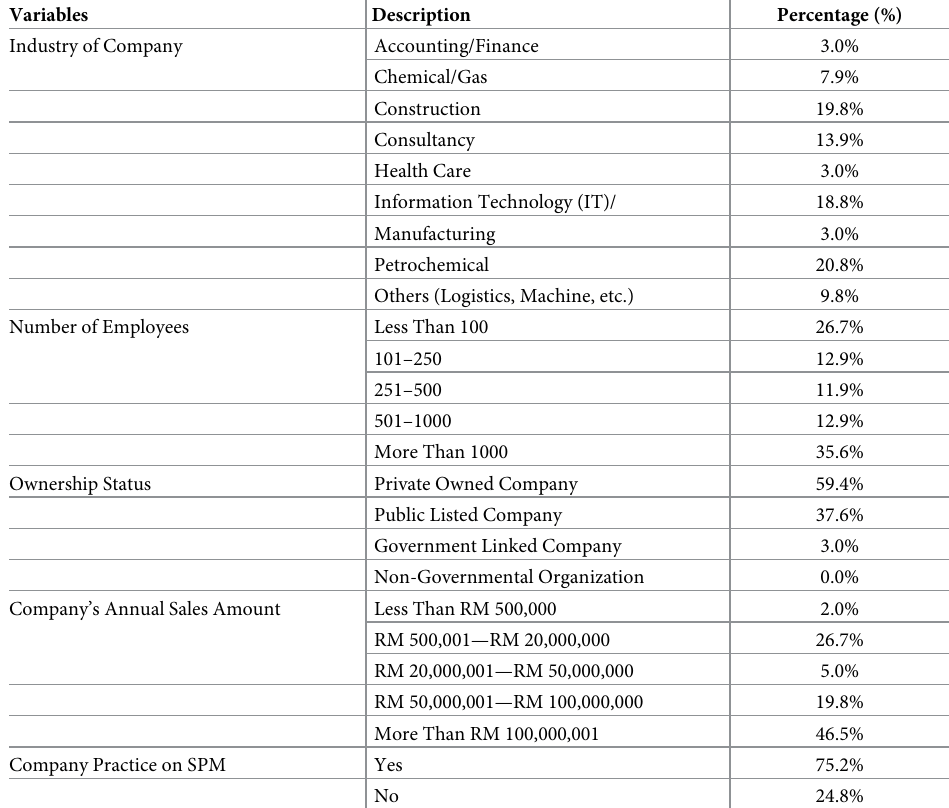
Table 2. Profile of respondents’